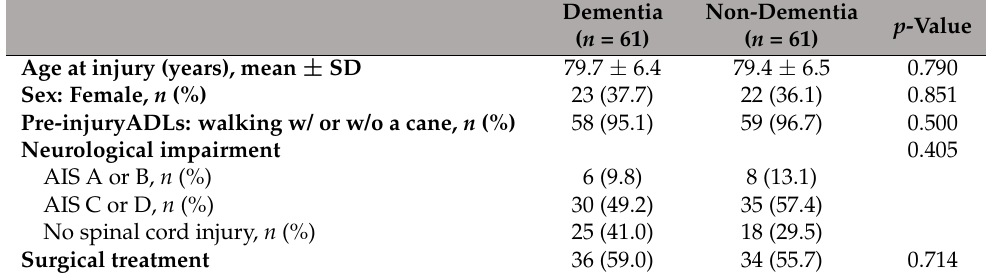
Table 3. Comparison of the adjusted variables between the propensity score-matched